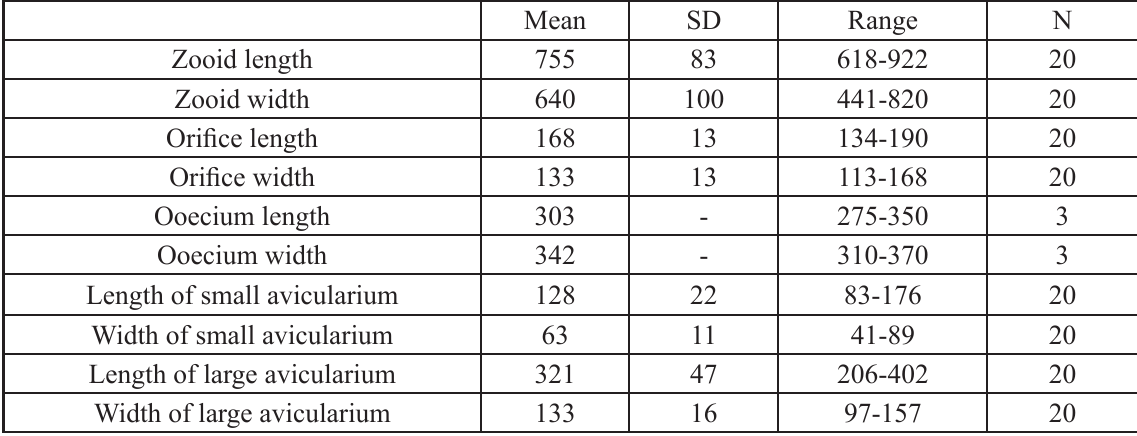
Table 3. Measurements (in µm) of skeletal characters of Hippomenella mucronelliformis (Waters, 1899), taken from specimens MM 3780 (lectotype), MMF 42297 (paralectotype) and nHMUK 1947.8.12.1. SD = standard deviation, n = number of